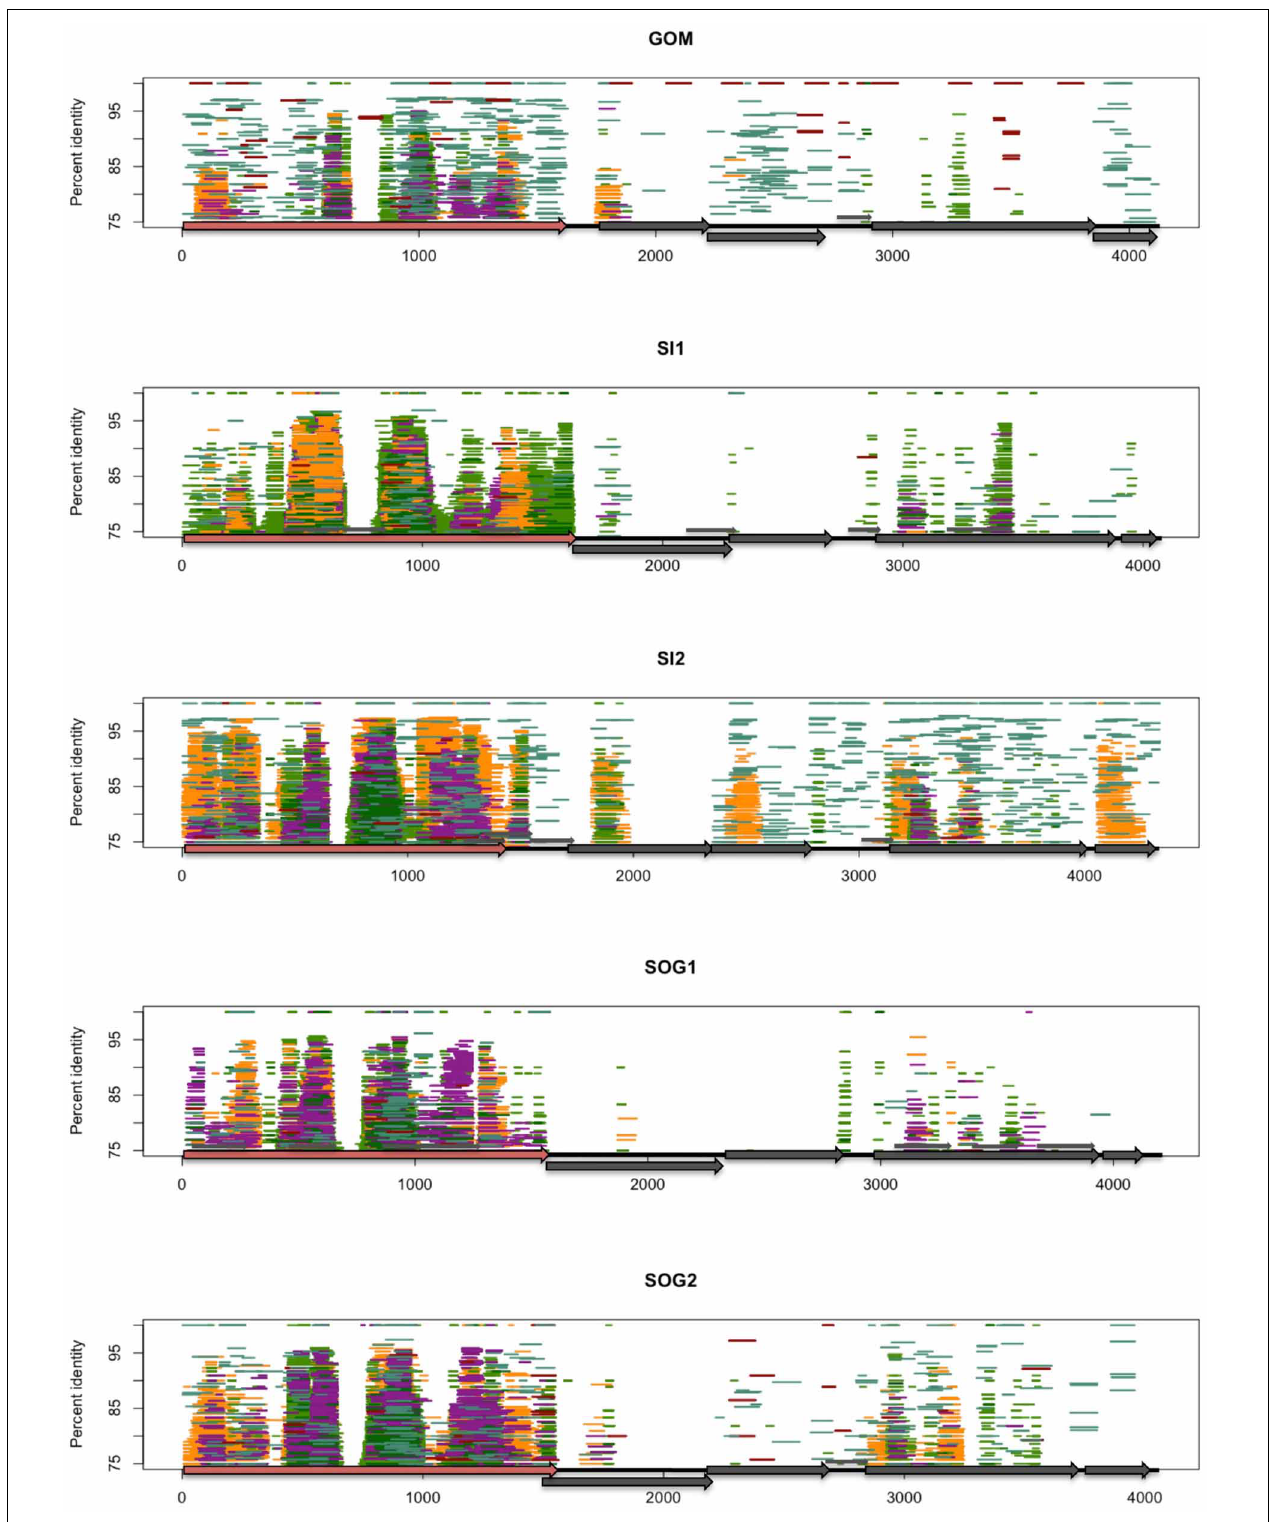
FIGURE 4 | Fragment recruitment of reads from environmental viral metagenomes to show the regions of conservation within different environments. Each assembled genome (GOM, SI1, SI2, SOG1, SOG2) is represented by a different panel. Each horizontal line represents a read recruited from one of the following publicly available metagenomic data sets: